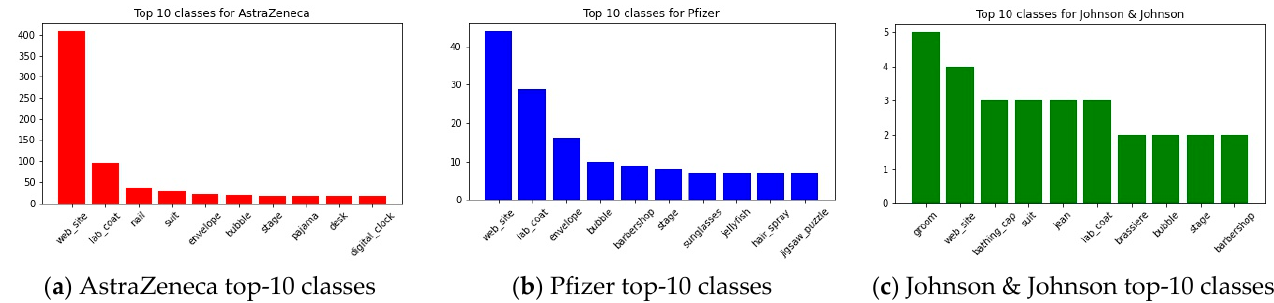
Figure 7. Top ‐ 10 classes for the three companies.